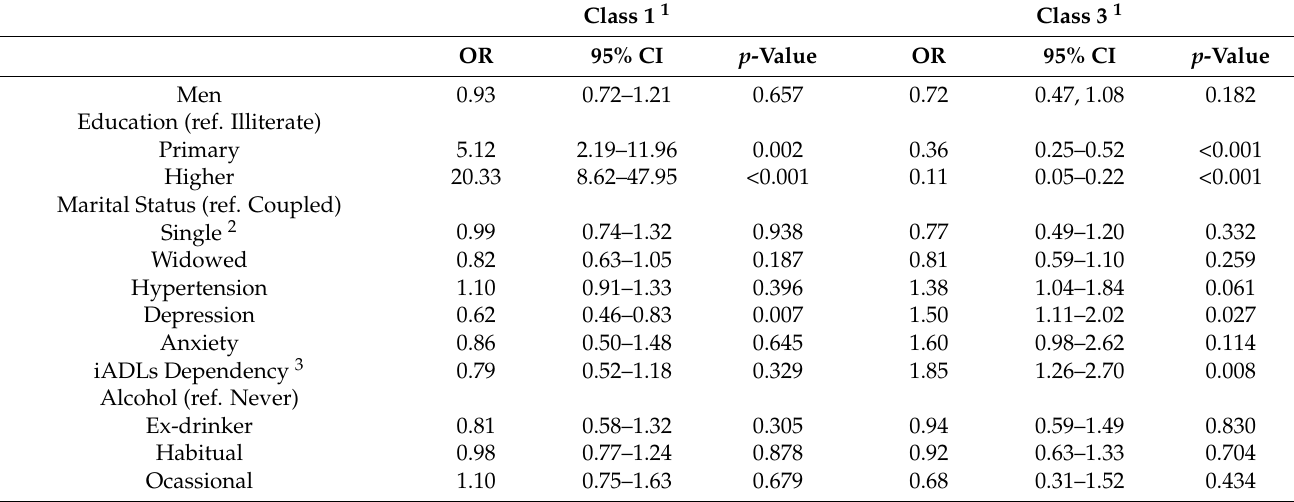
Table 4. Multinomial Logistic Regression of Predictors of Class